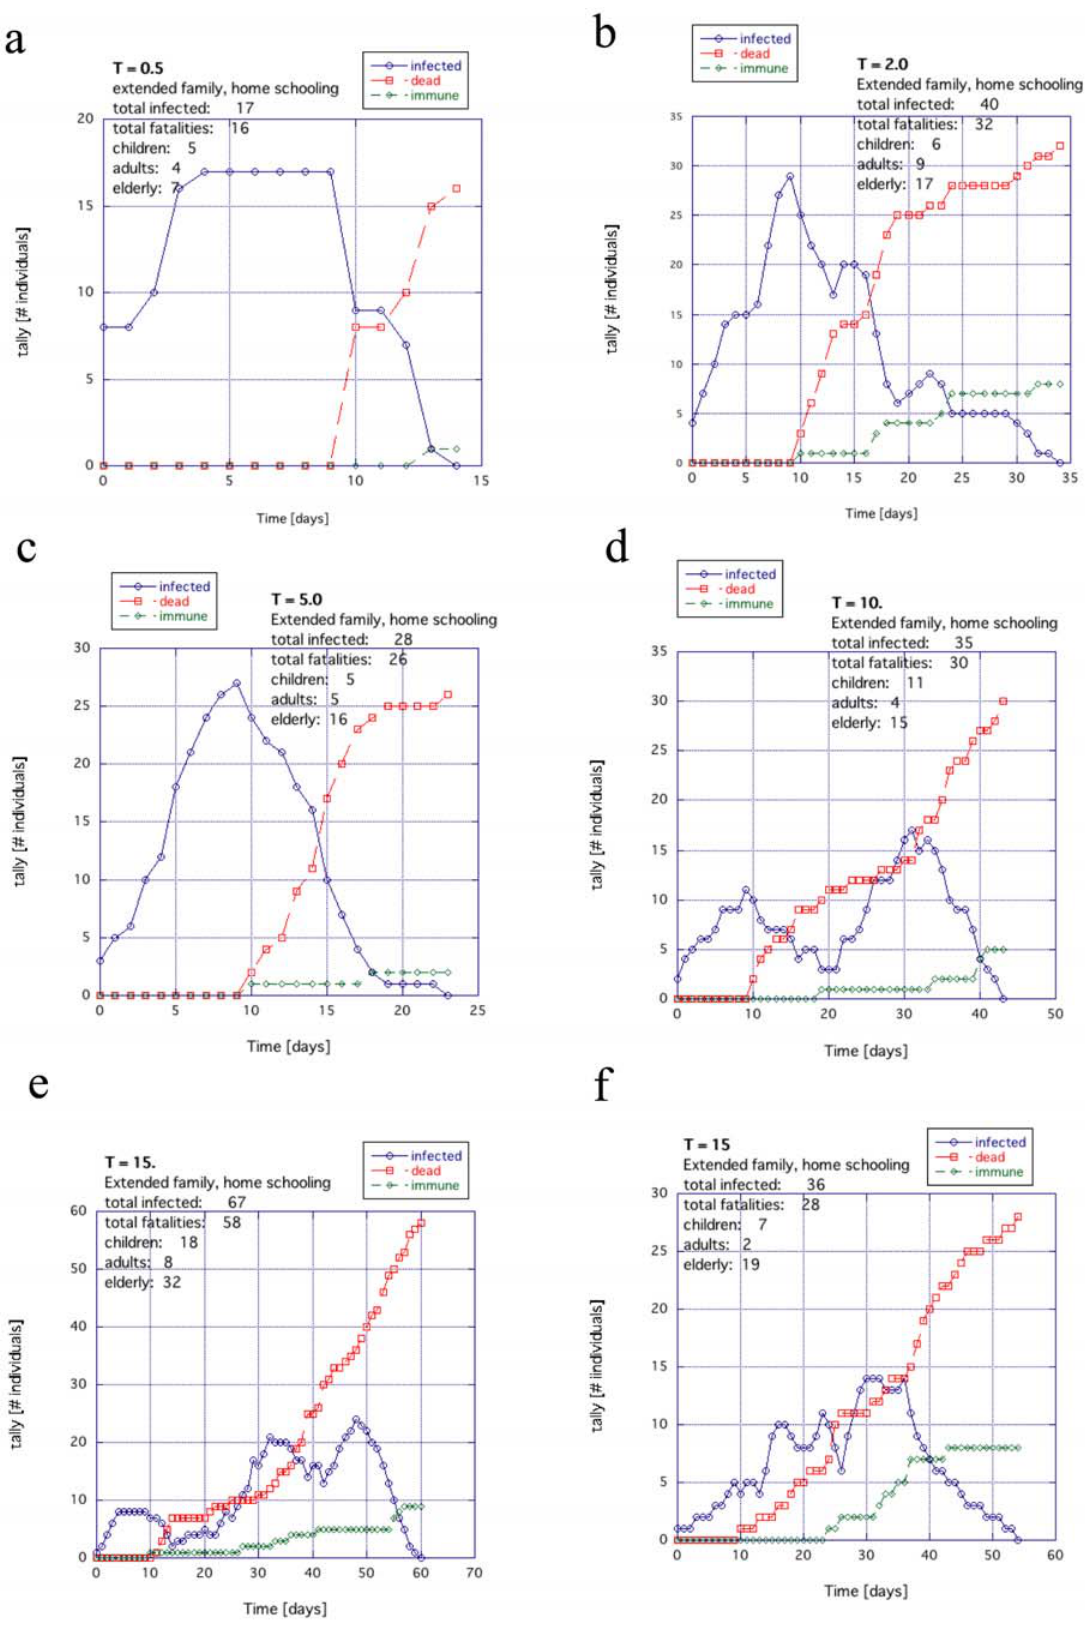
Figure 10. The general trend for temperature for the extended family example when the children are educated at home: (a) T ~ 0 : 5 , (b) 2.0, (c) 5.0, (d) 10.0 and (e and f) 15.0.